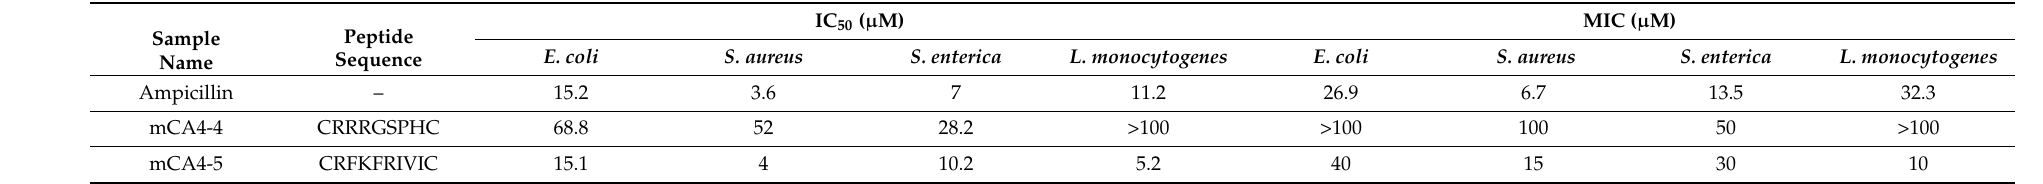
Table 2. IC 50 and MIC concentrations of Ang4-derived